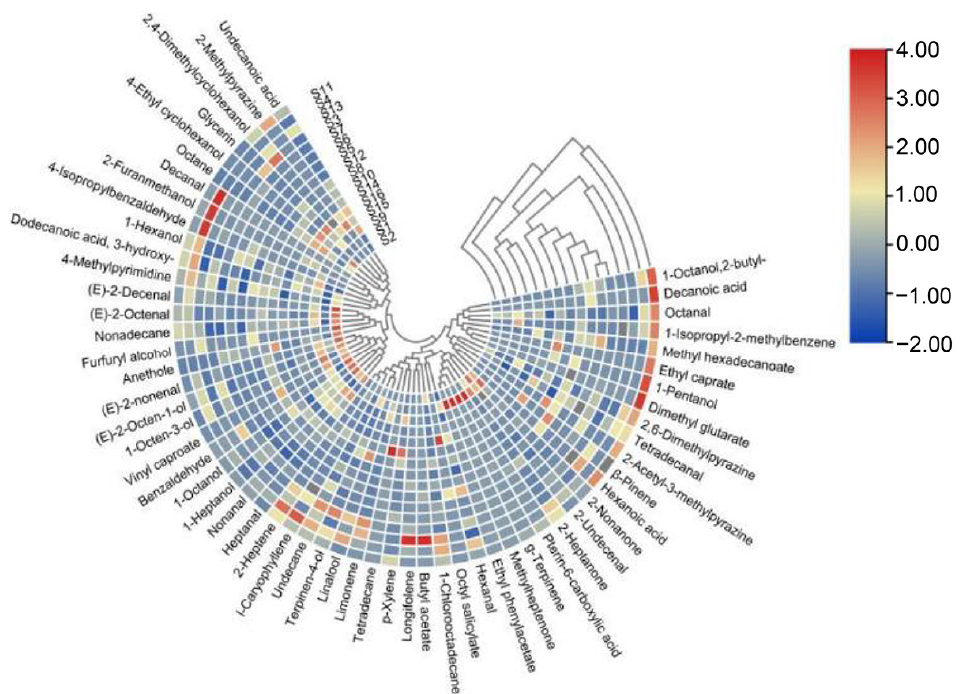
Figure 4. PCA results at the beef jerky samples of 59 volatiles.